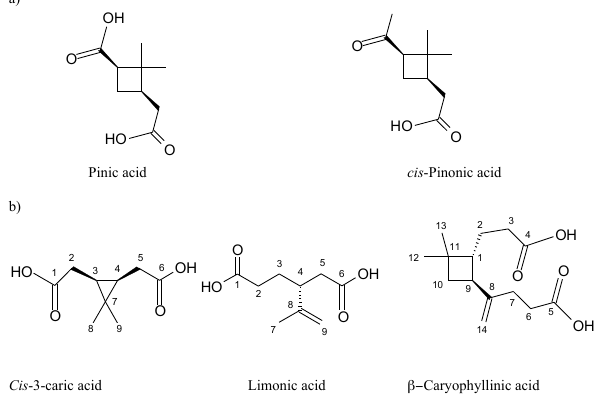
Figure 1. Structures of a) commercially available and b) synthesized terpenoic acids. The numbers refer to the C atoms in the NMR spectra.